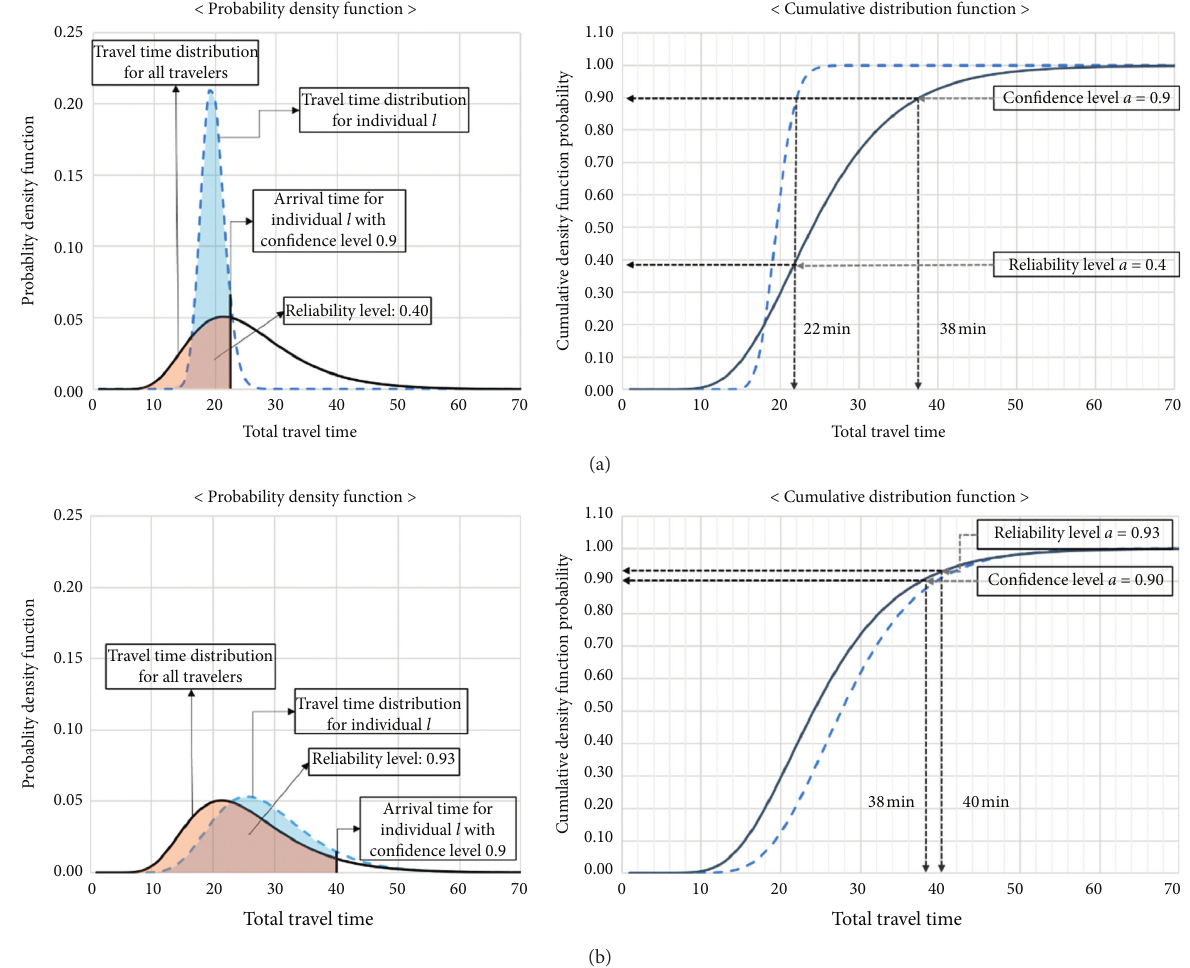
Figure 1: Distributional characteristics for risk preferences: (a) risk-seeking travellers; (b) risk-averse